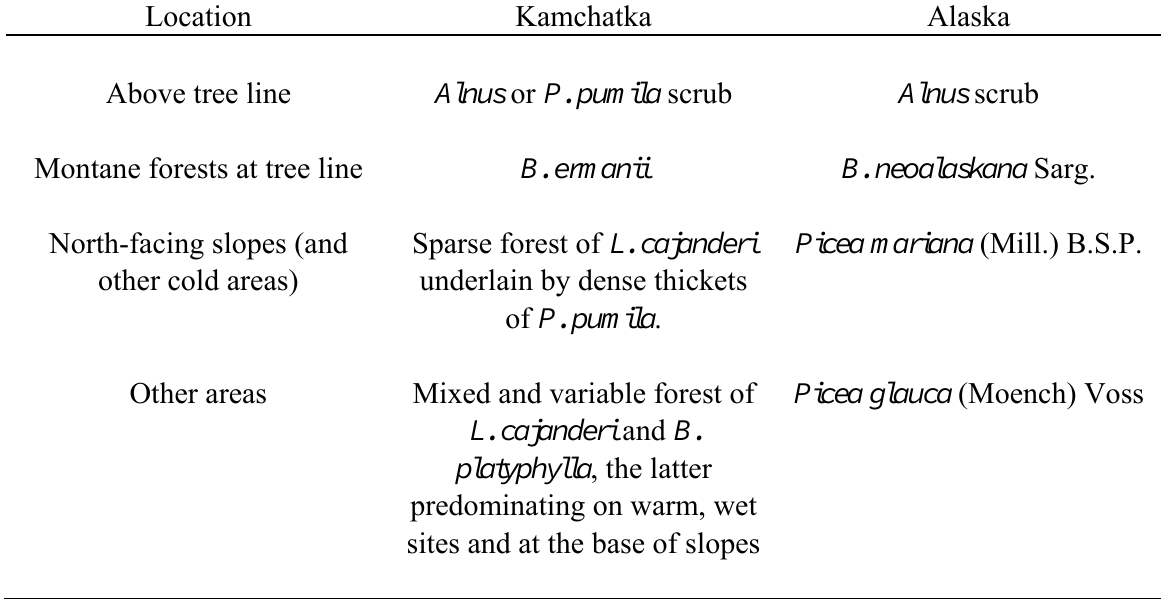
Table 10. Comparison of major forest types in central Kamchatka and central